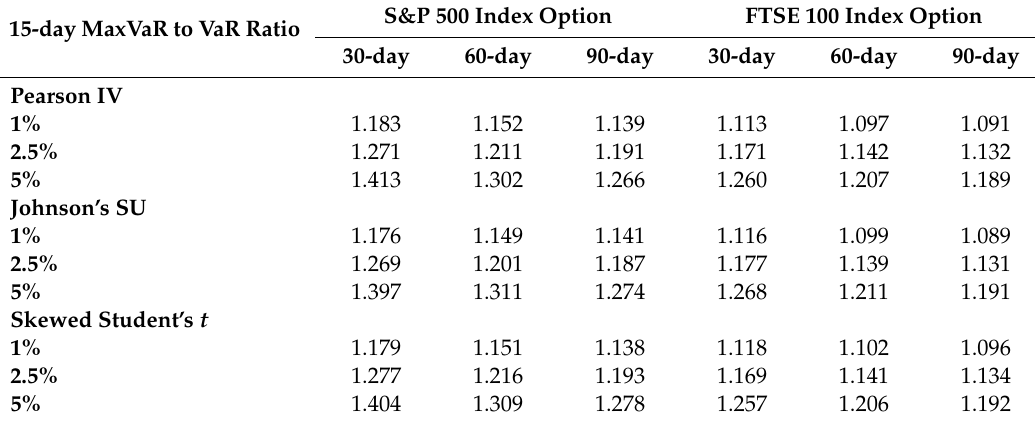
Table 7. Average 15-day Inflation